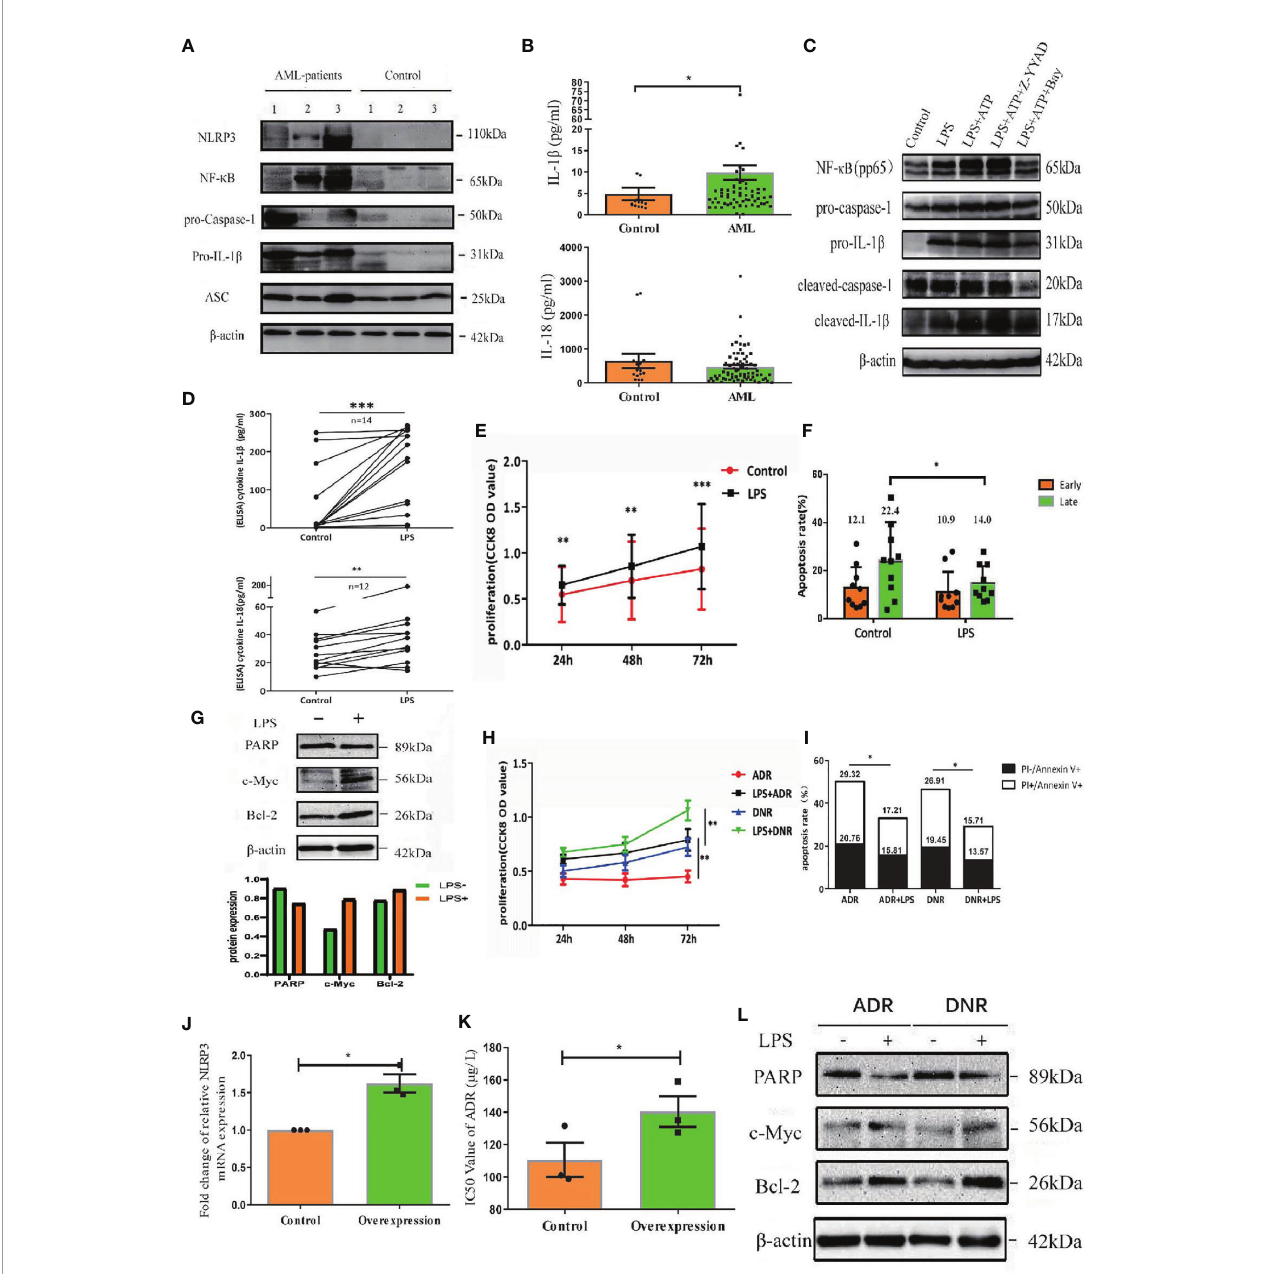
FIGURE 1 | NLRP3 in fl ammasome is over-expressed and highly activated in AML, which plays leukemia-promoting effects in vitro . (A) The western blot results of NLRP3, NF- k B, caspase-1, pro-IL-1 b and ASC in BM-MNCs from ND AML patients (n=3) and controls (n=3). (B) The concentrations of IL-1 b and IL-18 in BM supernatant from ND AML patients (n=70) in comparison to controls (n=15). (C) The Western blot results of pNF- k B, pro-caspase-1, pro-IL-1 b , cleaved caspase-1 and cleaved IL-1 b were showed in primary leukemia cells after different treatment. b -actin is used as a loading control. (D) LPS stimulated the secretion of IL-1 b and IL-18 into the supernatants from cultured leukemia cells. (E) CCK8 analysis was performed to detect the proliferation of leukemia cells 24, 48 and 72 hours after LPS stimulation (n=10). (F) The quanti fi ed apoptosis rate was shown (n=10). (G) The western blot results of PARP, C-myc and Bcl-2 in primary leukemia cells after LPS stimulation. (H) CCK8 analysis for the proliferation of primary leukemia cells with or without LPS 24, 48 and 72 hours after treatment with ADR, DNR (n=10). (I) The apoptosis results of primary leukemia cells with or without LPS after treatment with ADR, DNR (n=6). (J) The expression of NLRP3 in U937 cell line was enhanced after being transfected with lentivirus (n=3). (K) The IC50 value of ADR for U937 cells was higher after upregulating NLRP3 expression (n=3). (L) PARP, C-myc and Bcl-2 in primary leukemia cells after LPS stimulation (n=1). b -actin is used as a loading control. *P < 0.05; **P < 0.01; ***P <